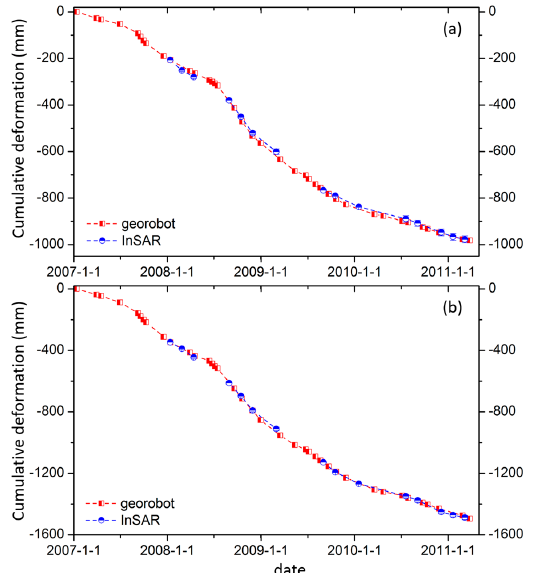
Figure 10. Time series deformation comparison between georobot and InSAR, ( a ) monitoring point TP04; ( b ) monitoring point TP08.